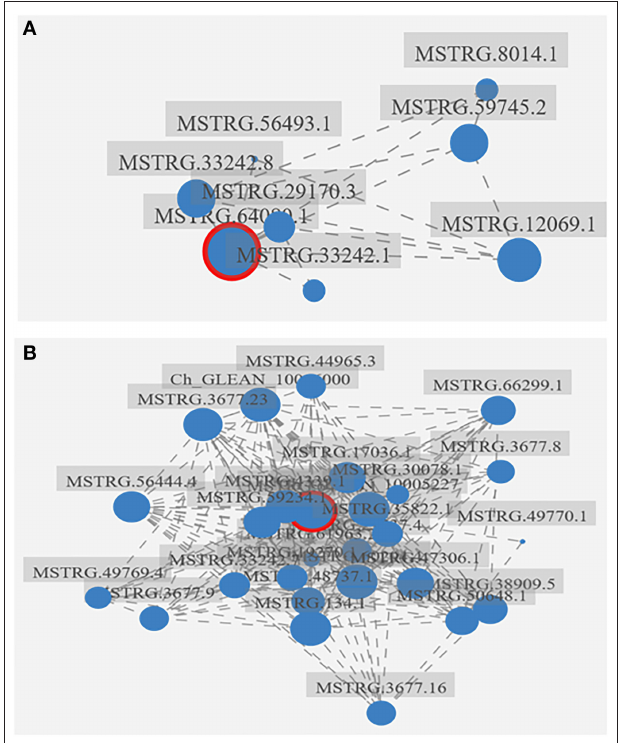
FIGURE 5 | The correlation network of HpGCN5 and genes involved in carotenoids biosynthesis, triacylglycerols biosynthesis, and transcriptional regulation. (A) The correlation network constructed by using SAHL transcriptome data; (B) the correlation network constructed by using SAHS transcriptome data. The HpGCN5 was red cycled. The big blue dots indicate the nod in the network, and the bigger the nod, the more correlated transcripts.